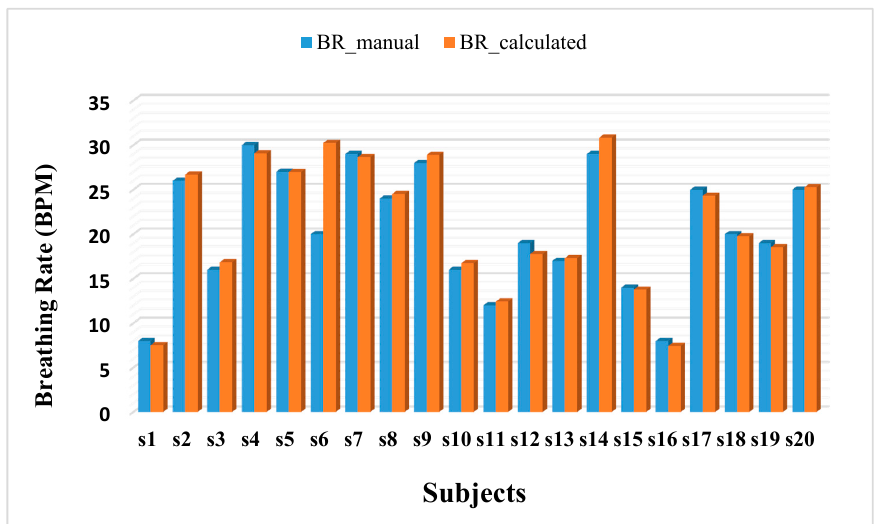
Figure 11. Breathing rates computed by the experimenter (BR_manual) and by calculating the TI and TE (BR_calculated) from the TBP signal.